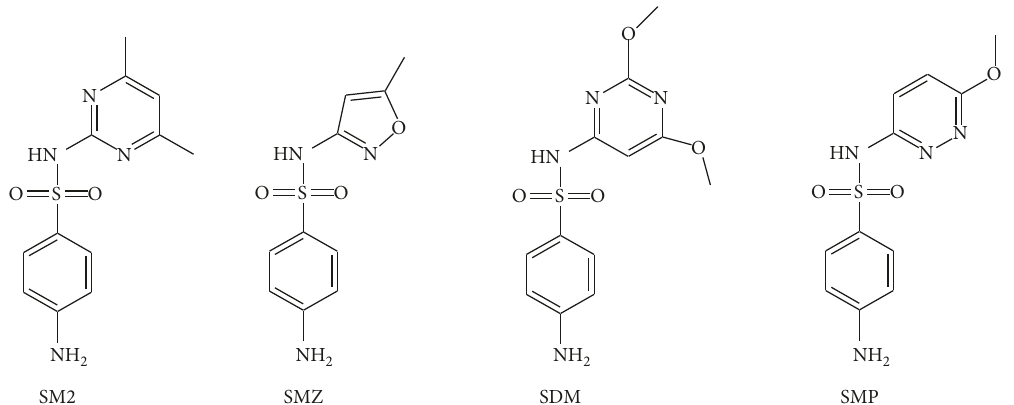
Figure 1: Chemical structures of SM2, SMZ, SDM, and